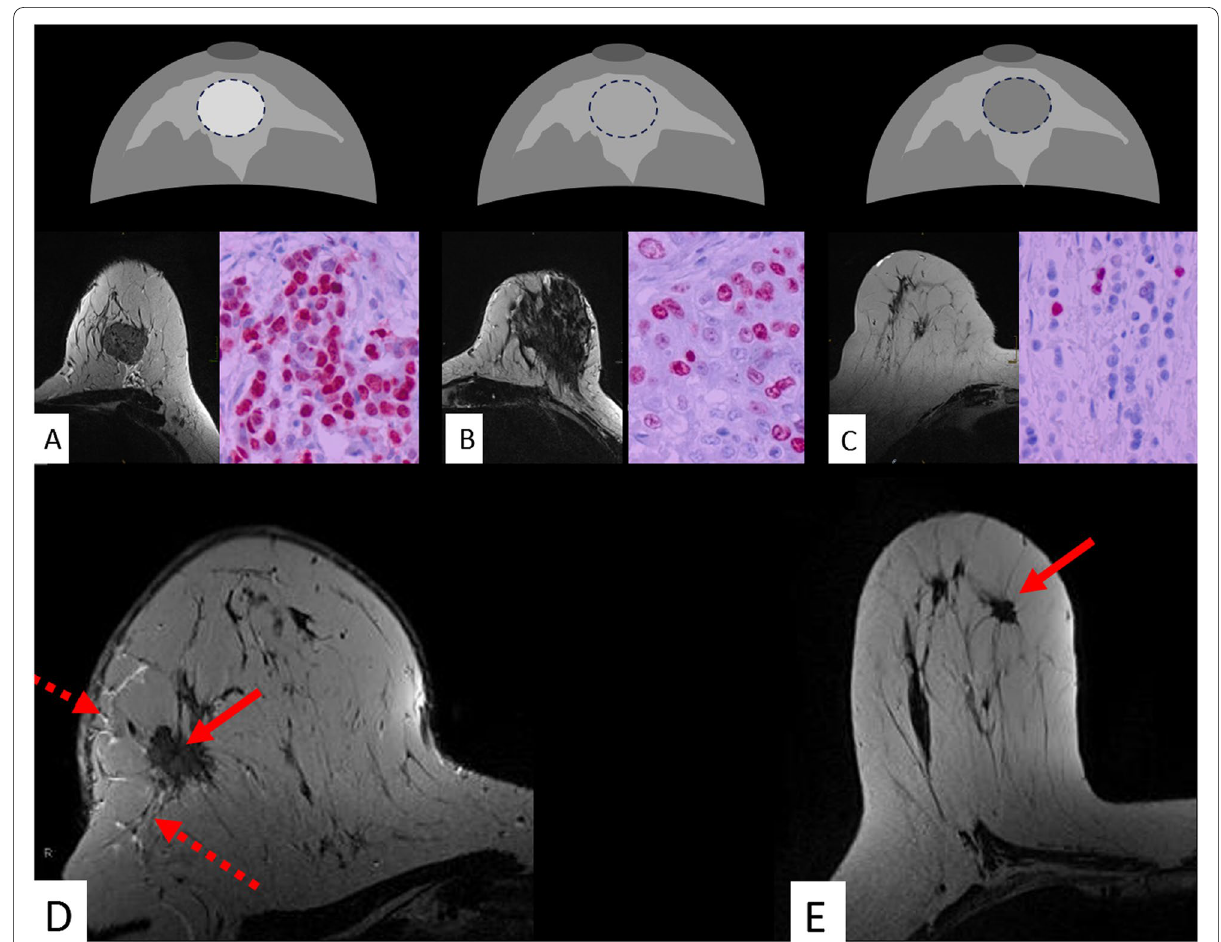
Fig. 4 Potential role of T2‑weighed images: the lesion signal as a possible surrogate of water content. Signal intensity on T2‑weighted images may reflect water content and warrants further scientific research. Compared to the surrounding parenchyma, a lesion is classified as hyperintense ( A ), isointense ( B ), or hypointense ( C ). In D , a mass lesion is identified on T2‑weighted images (red arrow). T2‑weighted signal intensity is assessed in comparison with the surrounding parenchyma. In D , just like the adjacent Cooper ligaments, the parenchyma displays less signal than the tumour. Correspondingly, the tumour is classified as “hyperintense”. Findings suggest the presence of an aggressive breast carcinoma phenotype. Predictive/ prognostic findings were verified by immune histology revealing high‑grade cancer with negative steroid receptors and elevated Ki‑67 suggesting high cellular proliferation. Note perifocal and subcutaneous oedema (dotted arrows). In contrast, E displays a hypointense less aggressive carcinoma (red arrow, G2, positive steroid receptors, only Ki‑67 +